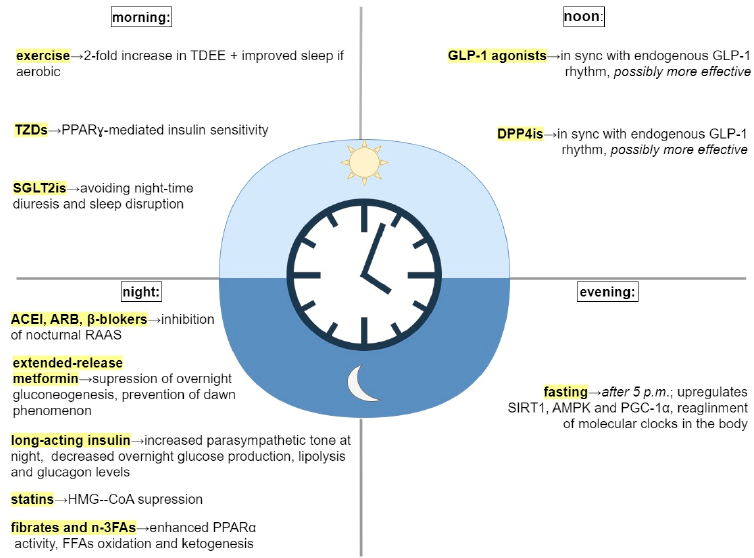
Figure 2. Treatment interventions and their timing. Abbreviations: TDEE, total daily energy expenditure; TZDs, thiazolidinediones; PPAR γ , proliferator − activated receptor γ ; SGLT2is, sodium − glucose transport protein 2 inhibitors; GLP − 1, glucagon − like peptid − 1; DPP4is, dipeptidyl peptidase − 4; SIRT1, sirtuin1; AMPK, adenosine monophosphate (AMP) activated protein kinase; PGC − 1 α , peroxisome proliferator-activated receptor − gamma coactivator 1 α ; ACEI, angiotensin − converting enzyme inhibitors; ARB, angiotensin receptor blocker; RAAS, renin − angiotensin − aldosterone system; HMG − CoA, β− hydroxy − 3-methylglutaryl − CoA; n − 3FAs, omega − 3 fatty acids; PPAR α , proliferator-activated receptor α ; FFAs, free fatty acids.